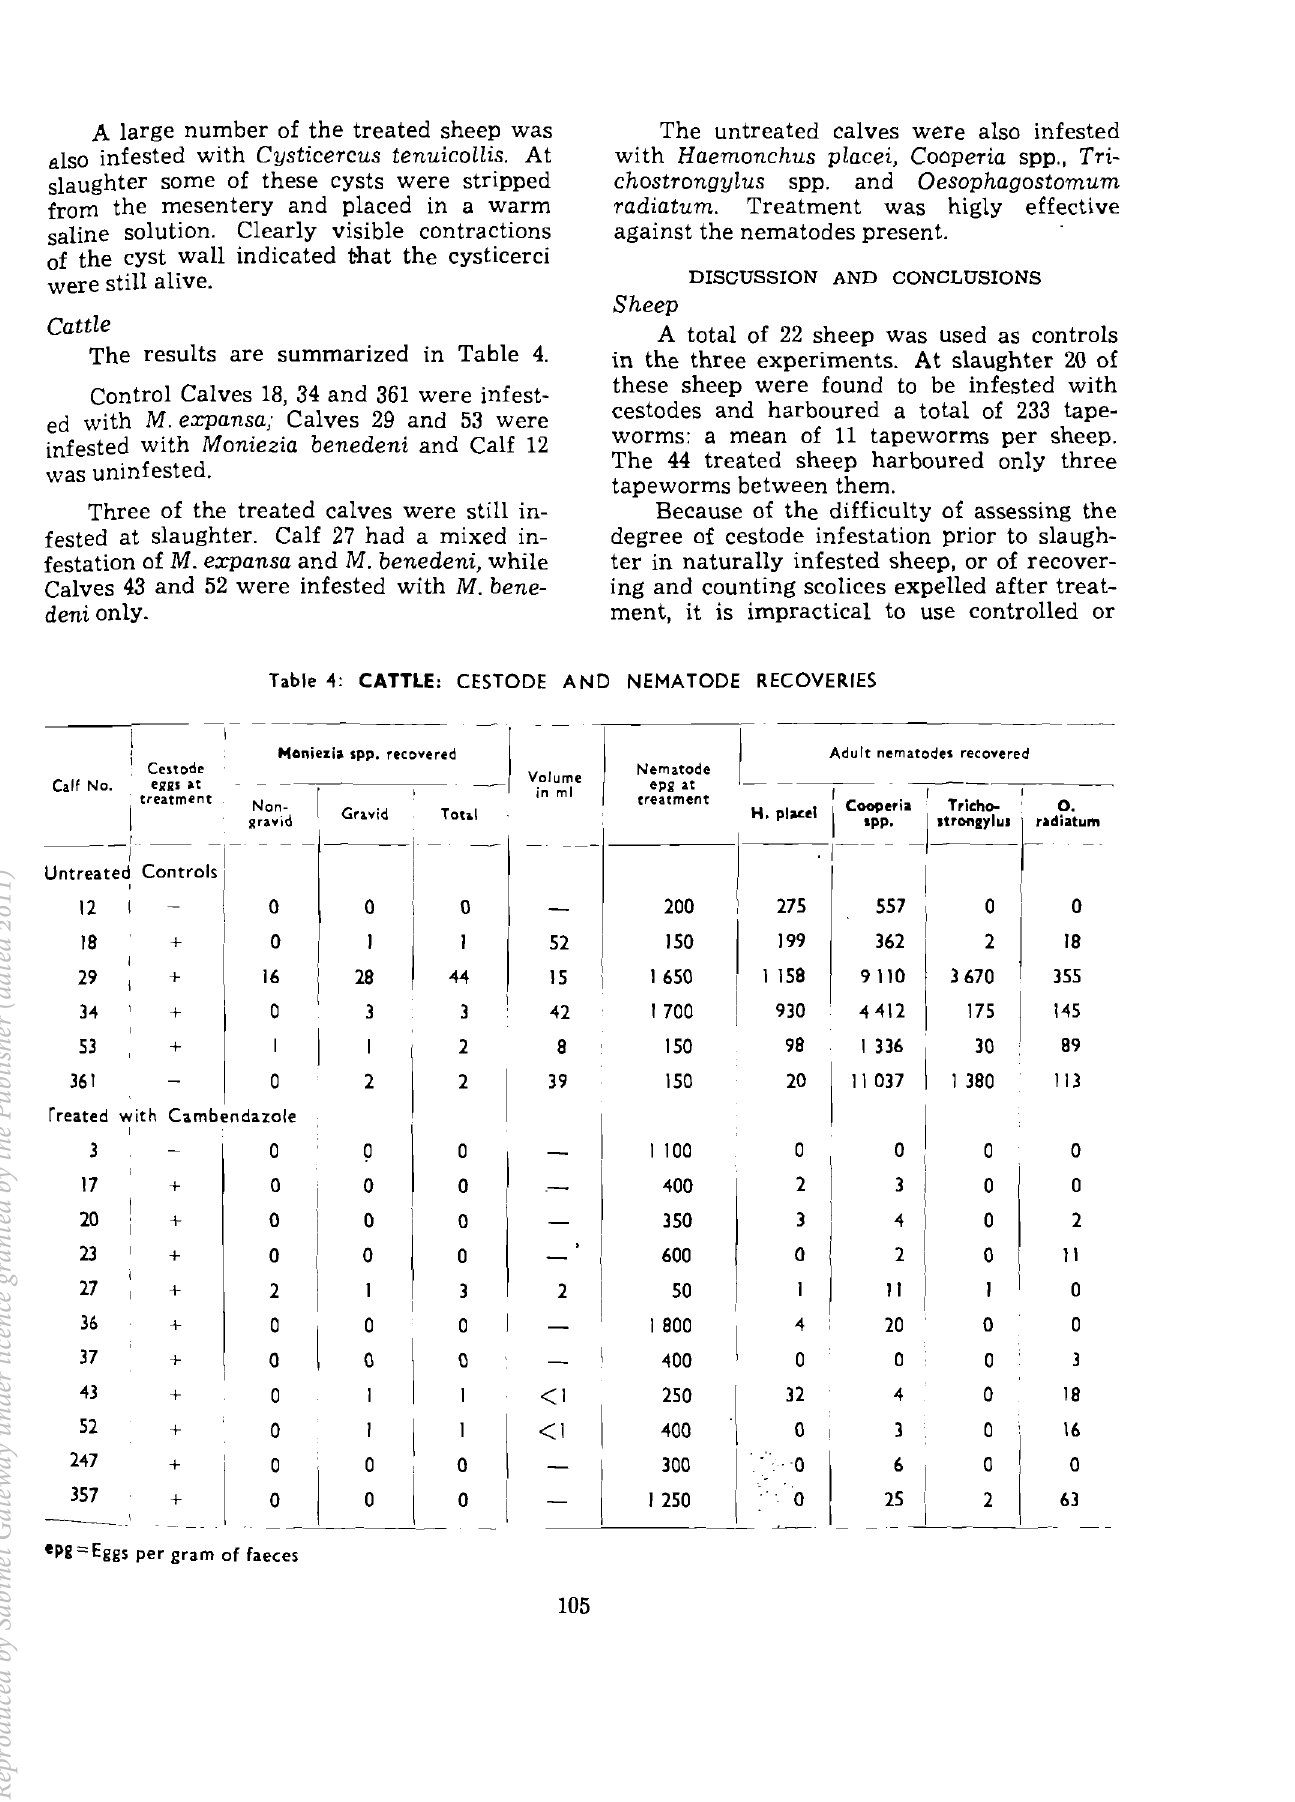
Table 4: CATTLE: CESTODE AND NEMATODE